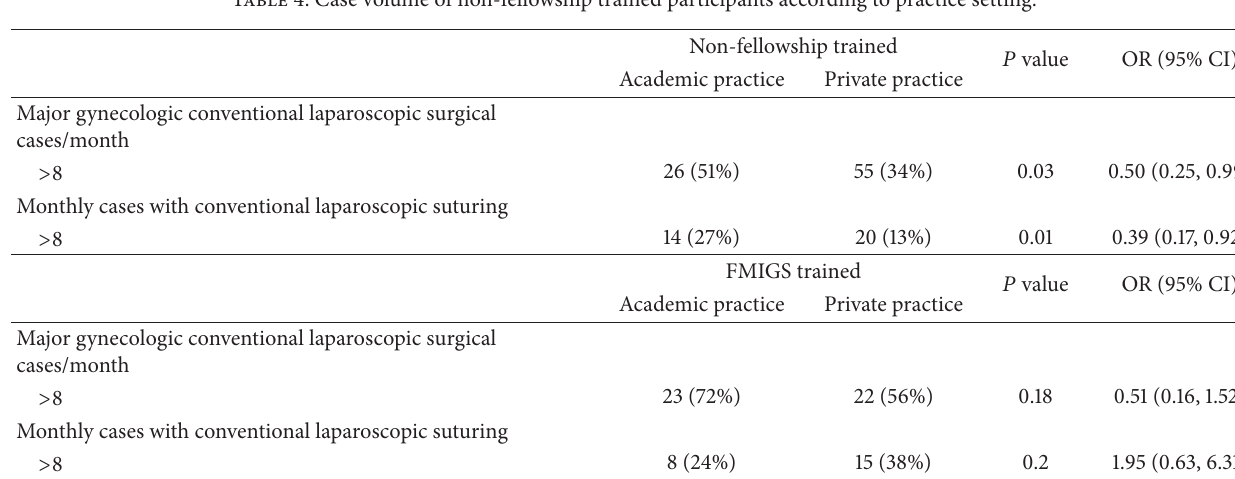
Table 4: Case volume of non-fellowship trained participants according to practice setting. Non-fellowship